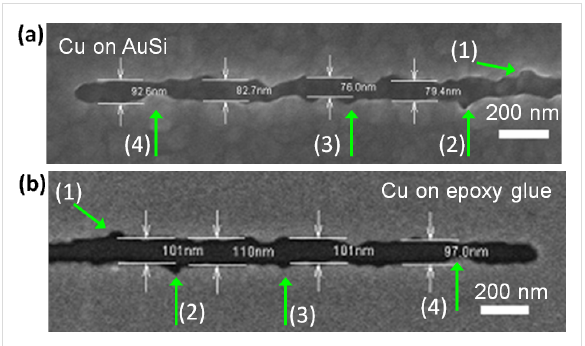
Figure 7: SEM images of a SAM templated copper deposit on the orig- inal MBP0 coated Au/Si substrate (a) and after transfer to epoxy glue (b). The passivating line of the cross-linked SAM was written by using an e-beam dose of 750 mC/cm 2 . Deposition parameters are − 0.7 V for 1 s, − 0.25 V for 20 s. The numbered green arrows mark the corres- ponding features in (a) and